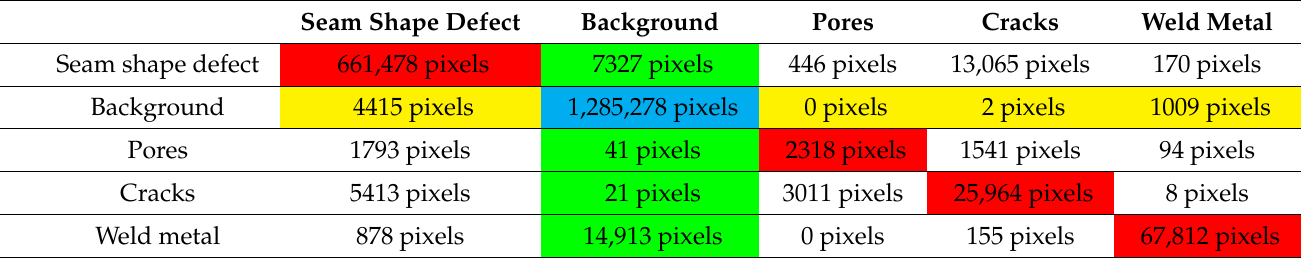
Table 1. Confusion matrix example for segmantation result 1; see Section 4.1. TP = blue, FP = yellow, FN = green and TN =